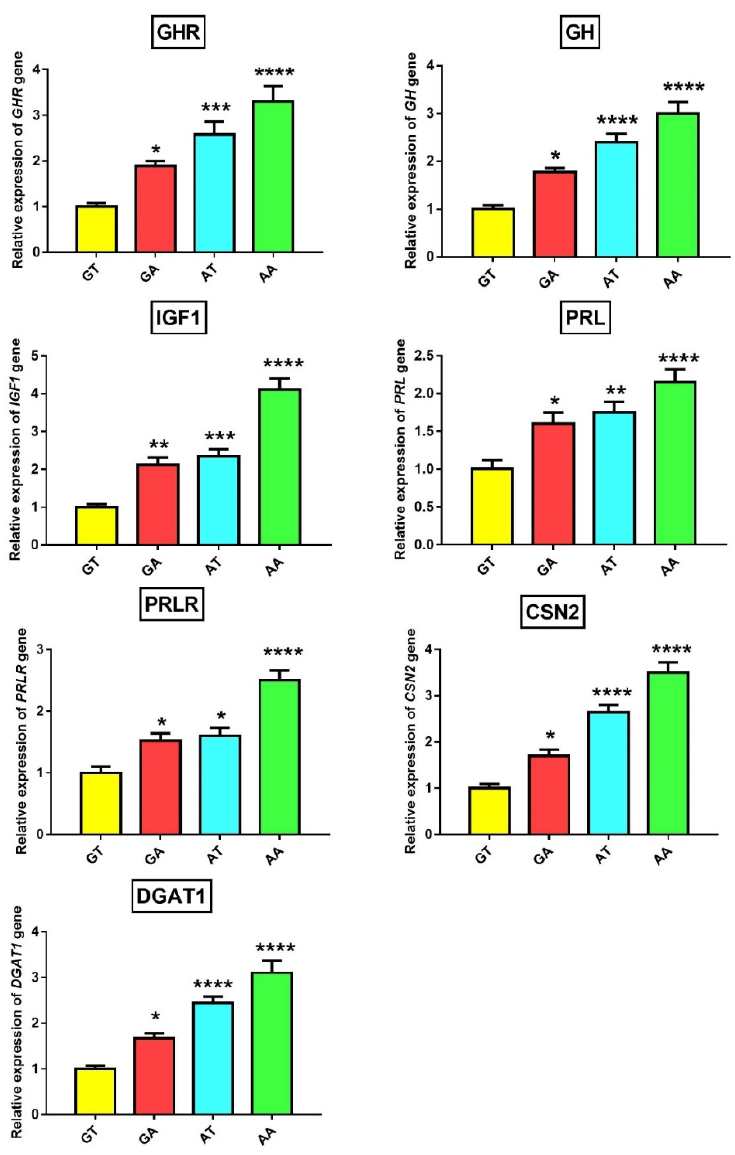
Figure 2. Associations between GT, GA, GT, and AT haplotypes and expression of GHR , GH , IGF1 , PRL , PRLR , CSN2 , and DGAT1 genes in milk somatic cells as detected by qRT-PCR. The β -actin gene was used as an internal control and data are presented as mean of gene expression fold change ± SEM (n = 9 / haplotype) with wild haplotype GT considered as the baseline. * p < 0.05, ** p < 0.01, *** p < 0.001, and **** p < 0.0001. All p -values were obtained using Bonferroni’s correction for comparison of all haplotypes against wild haplotype GT.